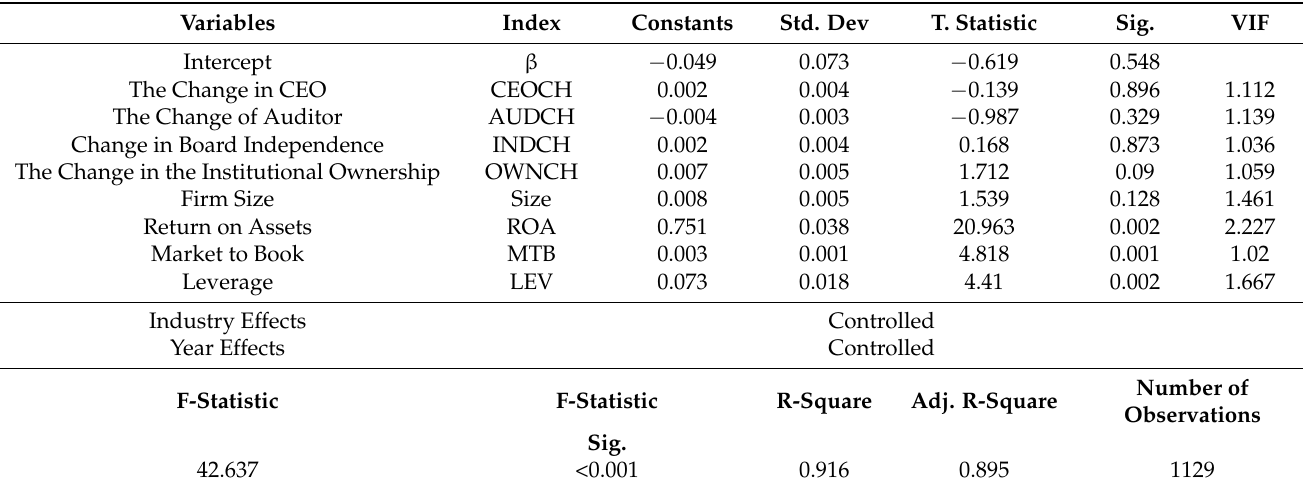
Table 3. The results of the second hypothesis model.